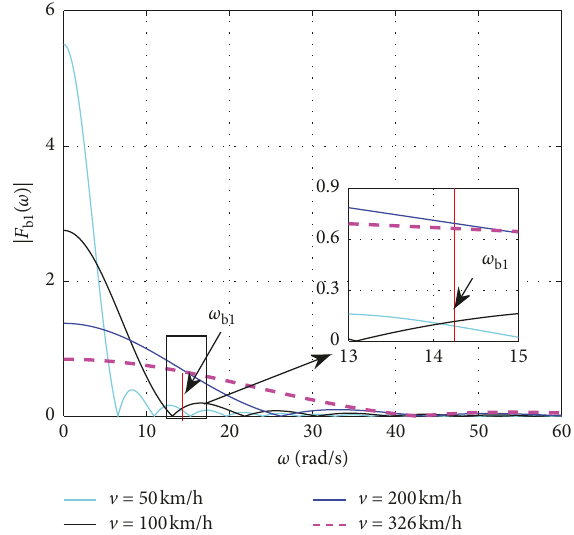
Figure 7: Amplitude spectrums of the moving constant loads.